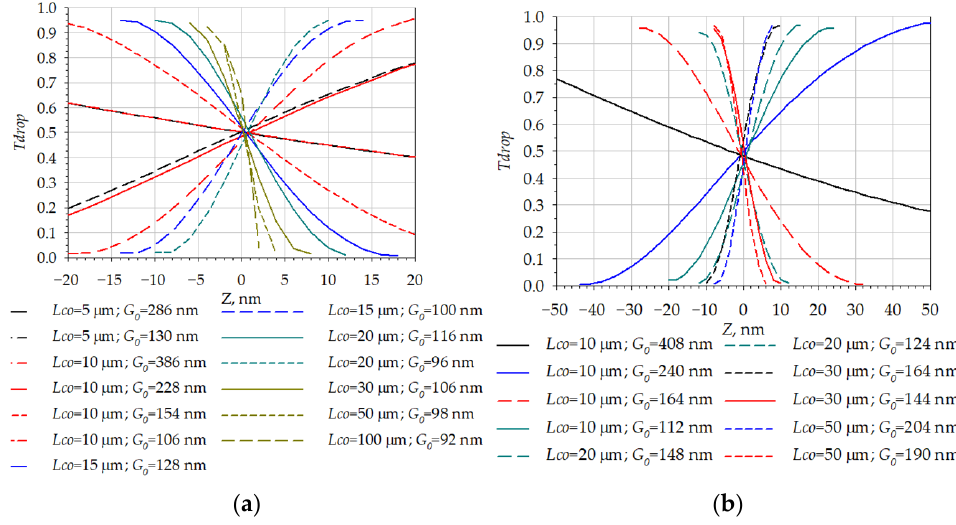
Figure 16. Dependencies of the optical transmission coefficient on the inertial mass linear displace- ment along axis Z for the OMT with different-plane waveguides (Scheme 9). ( a ) Waveguides with dimensions of 300 × 1000 nm; ( b ) Waveguides with dimensions of 300 × 750 nm.